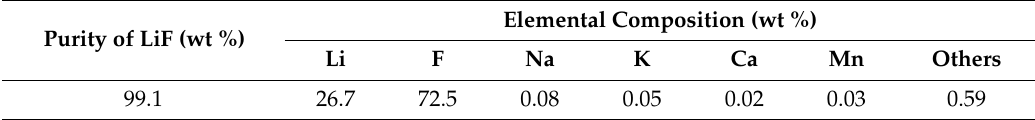
Table 4. Purity of LiF.